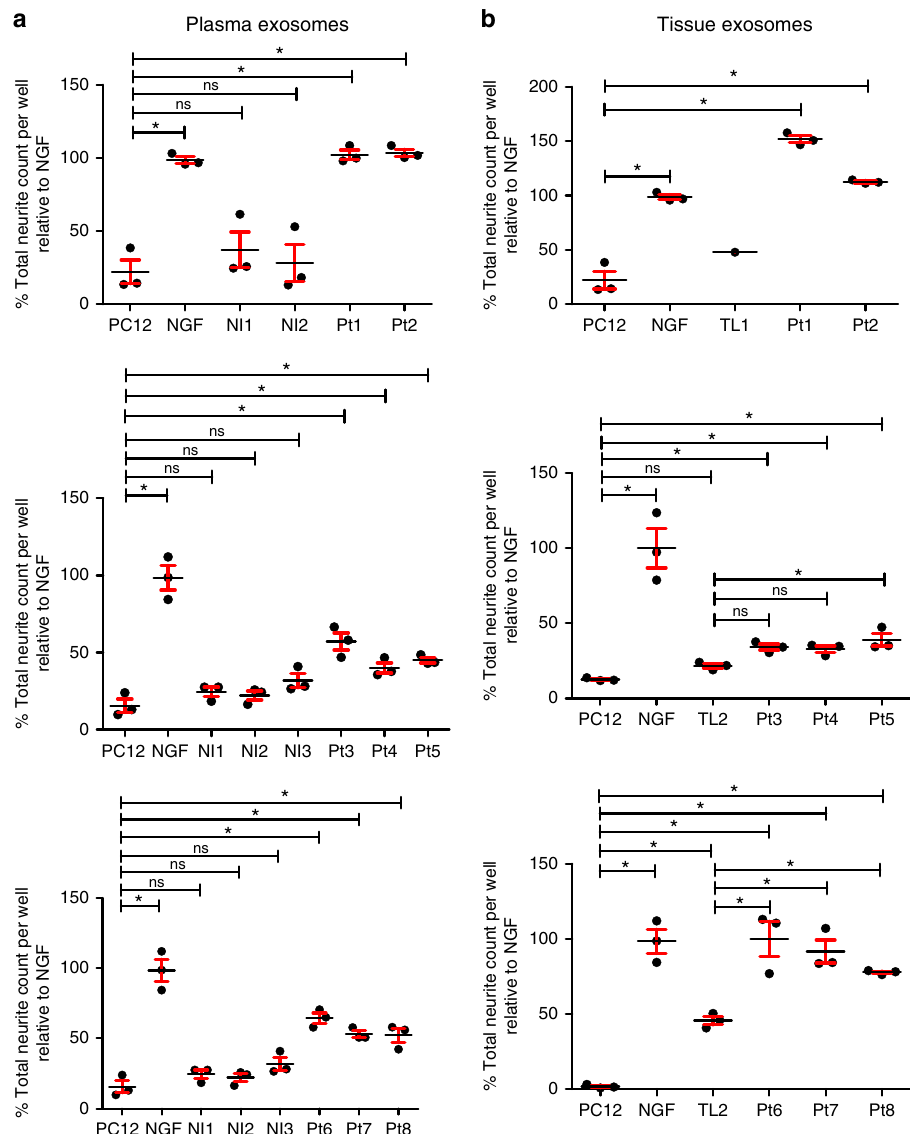
Fig. 3 Head and neck cancer patient derived exosomes induce neurite outgrowth. Quanti fi ed neurite outgrowth of PC12 cells following plasma ( a ) or tissue ( b ) exosome stimulation. NGF (100 ng/ml) serves as a positive control. Nl1- Nl3 non-cancer control blood, Pt1-Pt8 cancer patients, TL1,2 normal tonsils. n = 3 technical replicates/sample; assay repeated at least n = 2 times with similar results. The exosome yield from TL1 was low and insuf fi cient for multiple replicates. For statistical analysis, one-way ANOVA with post-hoc Fisher ’ s Least Signi fi cant Difference (LSD) test was used; LSD p values reported; * p ≤ 0.03; ns, not signi fi cant, center value used was the mean. Error bars, standard deviation. The variance between groups compared is similar. All comparisons and LSD p values found in Supplementary Tables